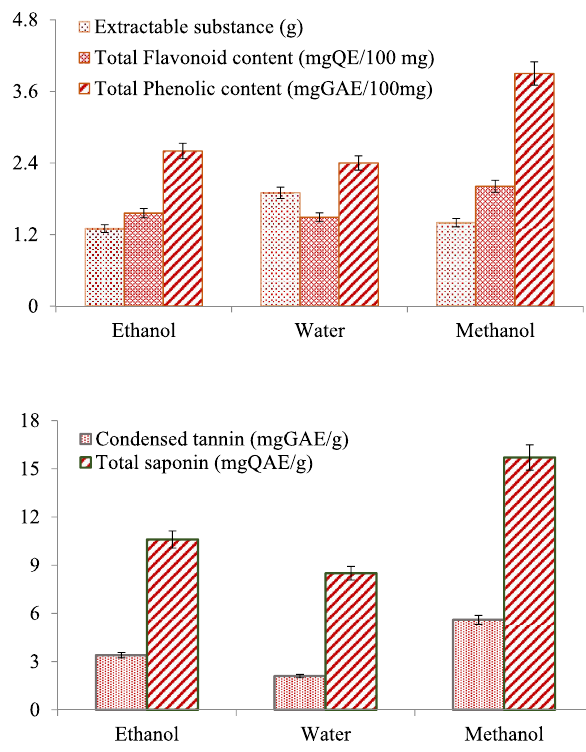
Figure 1. The amount of extractable substance, total phenolic, flavonoid, condensed tannin and saponin contents of A. lividus extract in different solvents. Each analysis was repeated three times and average values are